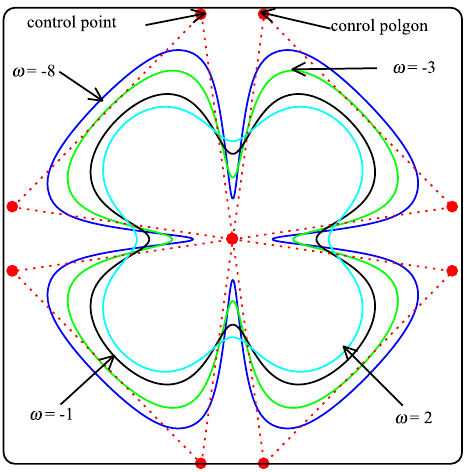
Figure 4. Parameter effects on the limit curves with initial polygon of binary scheme.